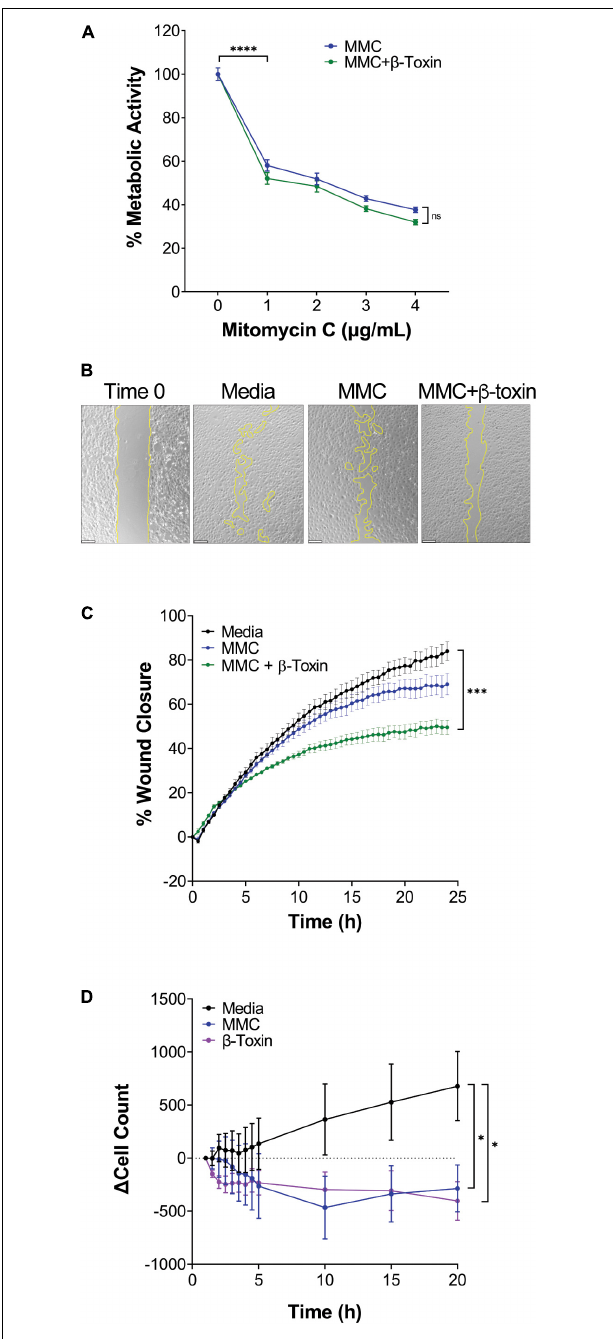
FIGURE 4 | β -toxin inhibits migration and proliferation. (A) Percent metabolic activity. iHAECs grown to near confluency on 1% gelatin-coated plates and treated for 24 h with mitomycin C (MMC) in the absence or presence of β -toxin (50 µ g mL − 1 ). ∗∗∗∗ p ≤ 0.0001; two-way repeated measures ANOVA. Unpaired, two-tailed t -test was used to compare individual MMC treatments to media control (0 µ g mL − 1 ). (B) Phase-contrast microscopy at Time 0 (representative image) and at 24 h for all conditions tested. Images captured every 30 min. Scale bar = 200 µ m. (C) Percent wound closure over time of iHAECs treated with MMC (2 µ g mL − 1 ) ± β -toxin (50 µ g mL − 1 ). All results are mean ± SEM of five independent experiments with four replicates each. (Continued)